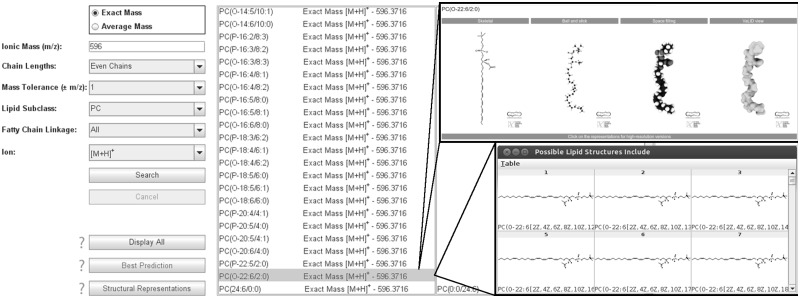
The VaLID interface